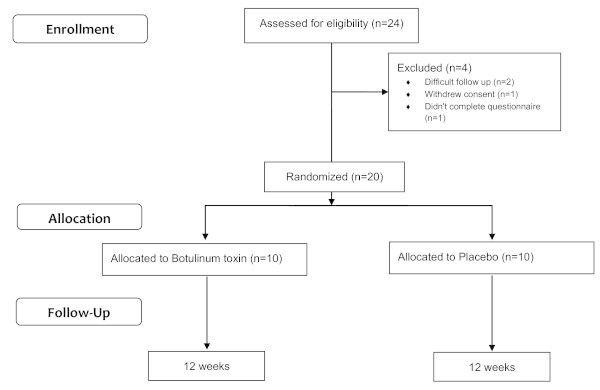
Study flow chart.